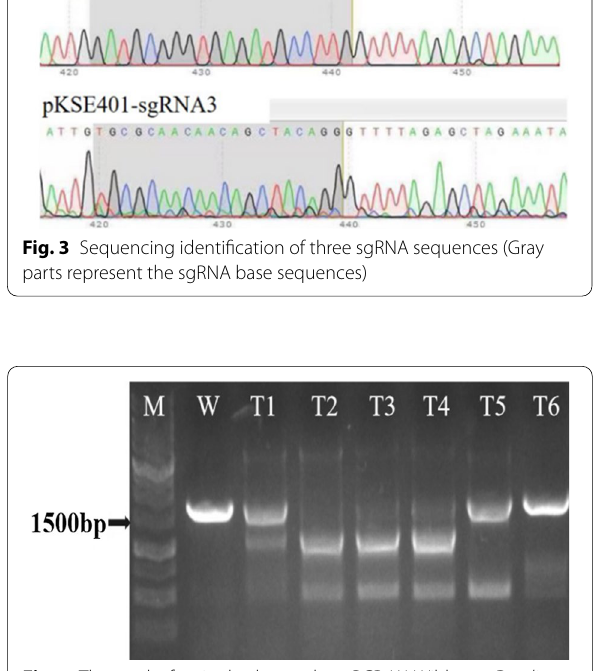
Fig. 4 The results for single algae colony PCR. W: Wild type D. salina strain; T1-6: Transformed D. salina lines